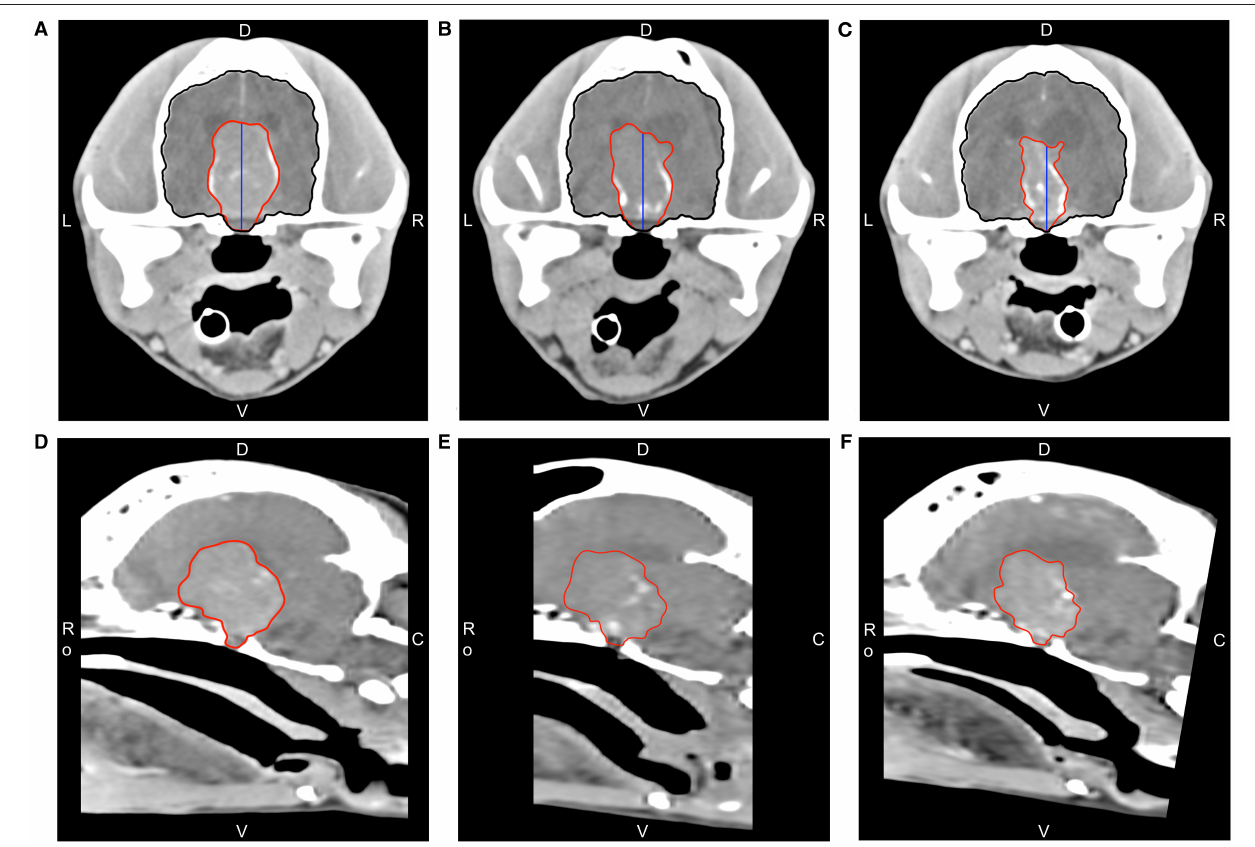
FIGURE 2 | CT with delineated tumor segmentation (red), brain segmentation (black), and pituitary height (blue) used for volume and P/B ratio measurements before and after holmium-166 microsphere treatment. Coronal slices of the pituitary mass at the level of the temporomandibular joint showing the largest transverse surface area before treatment (A) , after 51 days (B) , and after 138 days (C) . D = Dorsal, V = Ventral, L = Left, R = Right, Ro = Rostral, C = Caudal. Corresponding mid-sagittal slices before treatment (D) , after 51 days (E) , and after 138 days (F)